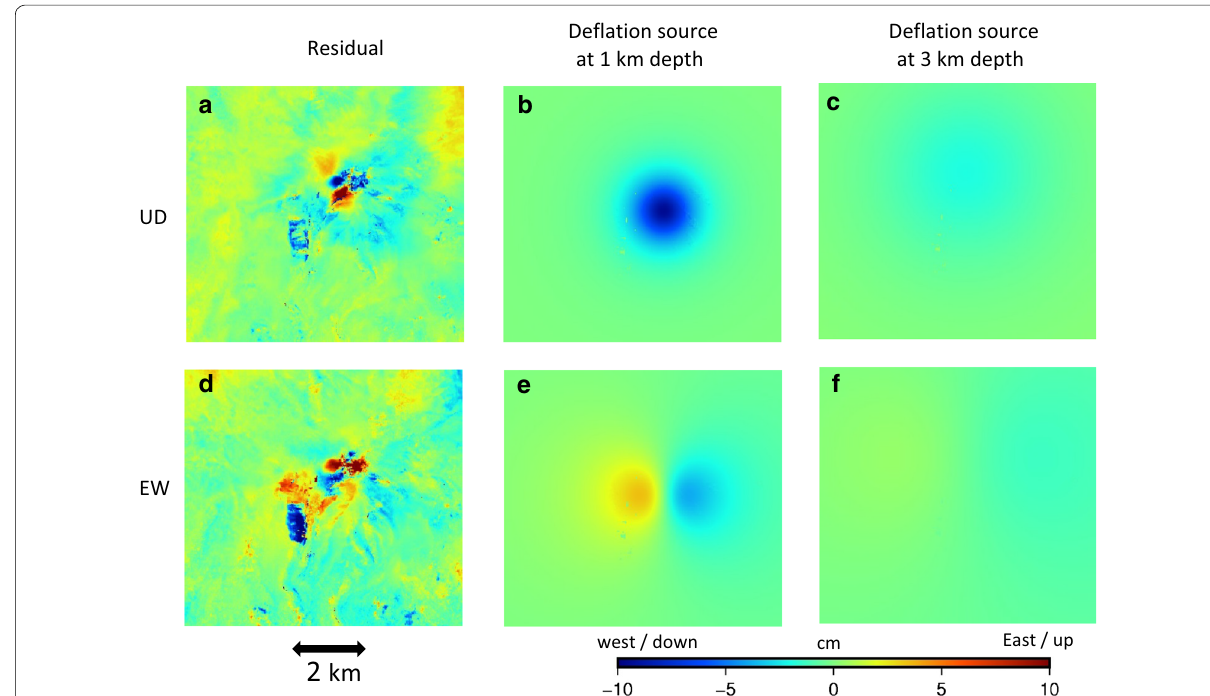
Fig. 8 Comparison between residuals for the best-fit FE model and the simulated deformations presumably caused by the sources proposed in Takagi and Onizawa (2016). a , d Residual images obtained by subtraction of the optimal FE model predictions (Fig. 5) from decomposed EW and UD component during the period between the end of September 2014 and the end of July 2015 (Fig. 4). Residuals remain in the close vicinity of the deflation center, where deformation might be complicated. For example, fractured and soft medium near the eruptive vents could amplify the deformation magnitude locally, or complex geometry of the deformation source, that is, not spheroidal source, could contribute to the locally amplified deformation. b , e Simulated deformations caused by the deflation source at 1 km depth. c , f Simulated deformations caused by